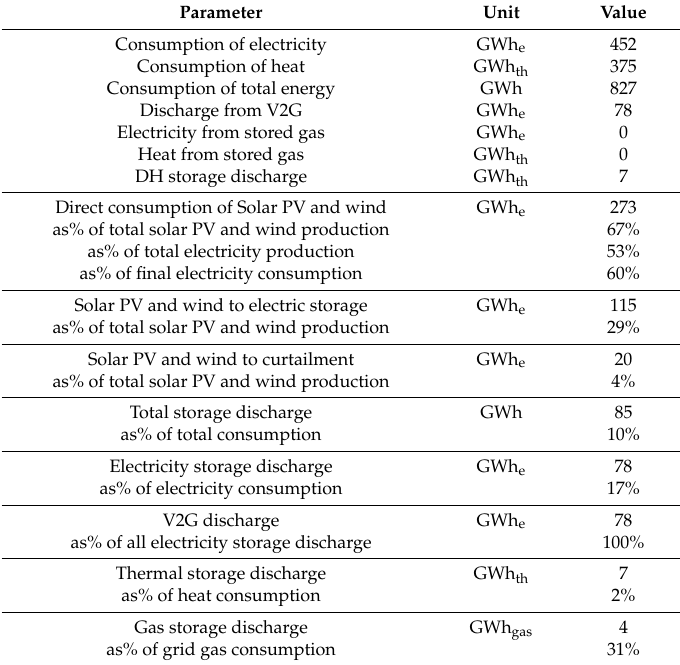
Table 2. Summary of calculations related to storage discharge and